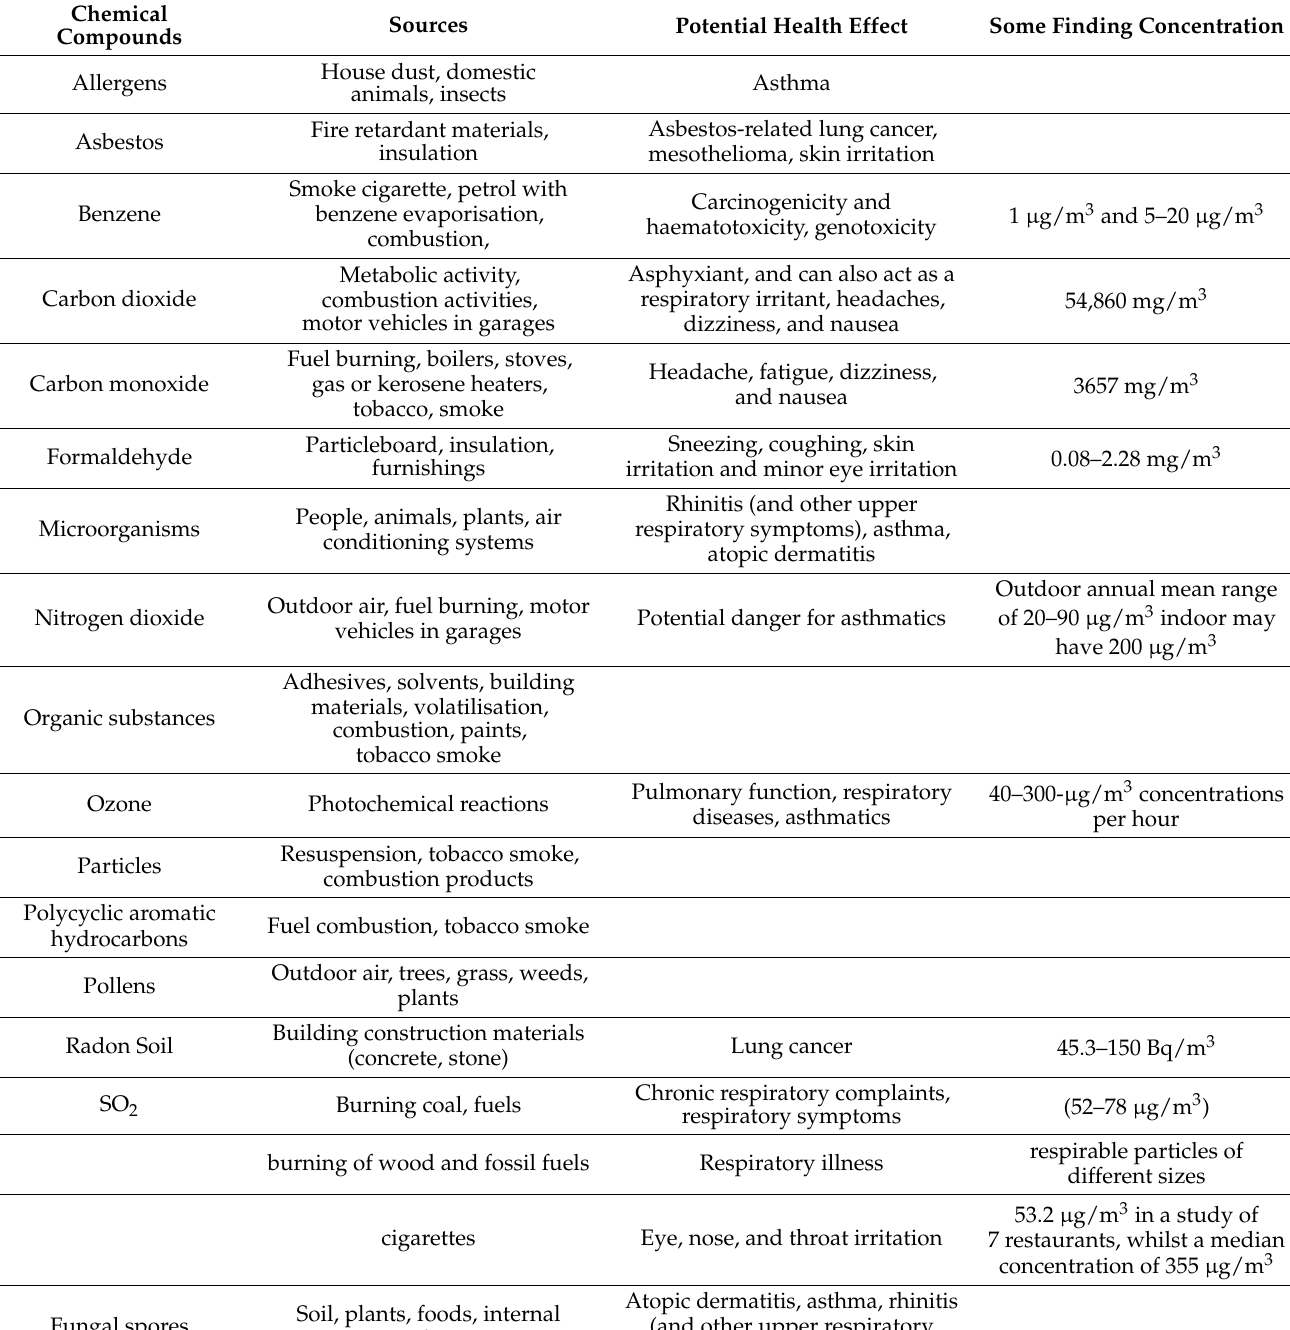
Table 1. Chemical compounds in the air in buildings, their sources and their potential health effects